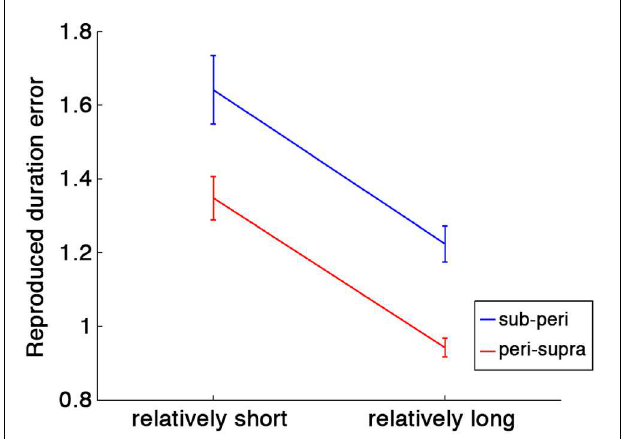
FIGURE 2 | Duration estimation errors calculated as ratios of the reproduced duration to the stimulus duration. Blue line indicates the duration estimation errors in runs with sub- and peri-second trials, and red line indicates the duration estimation errors in runs with peri- and supra-second trials. Error bars indicate standard errors (SE). Horizontal axis represents relative duration within each run: in runs with peri- and supra-second trials, for example, the peri-second durations are the relatively shorter durations and the supra-second durations are the relatively longer durations.